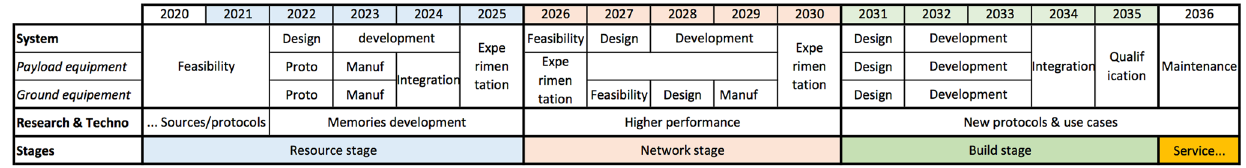
Fig. 4 An outline of the roadmap that can be considered to reach the service opening of a fi rst Space-based QIN. Some work of the resource stage has already been